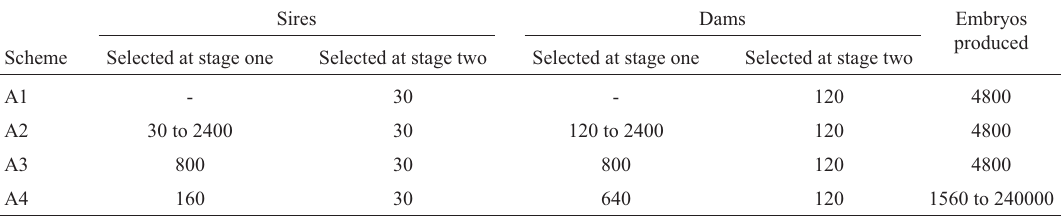
Table 2 - The number of sires and dams selected in first and second selection stages of each scheme and the number of embryos produced. Sires